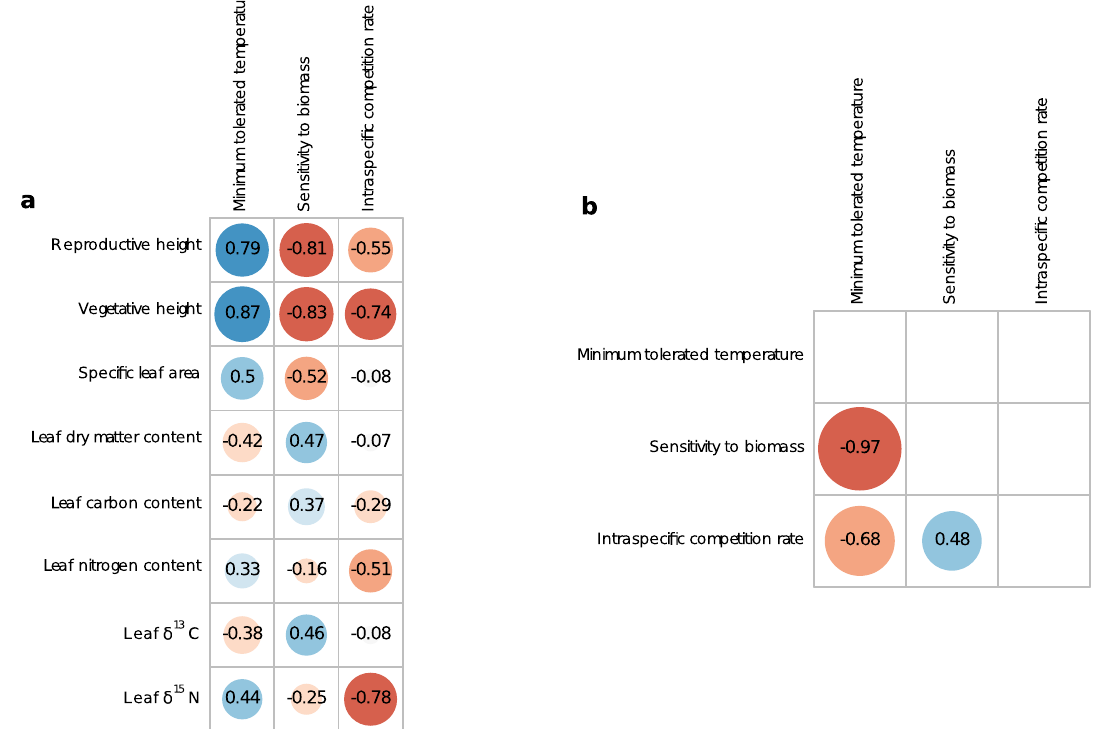
Fig. 3 Calibrated trait – demography relationships. Calibrated correlation between demographic parameters and empirical functional traits ( a ) and among demographic parameters ( b ). In each panel, numbers indicate the median of the Pearson ’ s correlation coef fi cients given by the posterior distribution. Circle size is proportional to the absolute value of the correlation coef fi cients and its color indicates the value of the correlation coef fi cients (with red representing a strongly negative correlation value, blue a strongly positive correlation and paler shades small